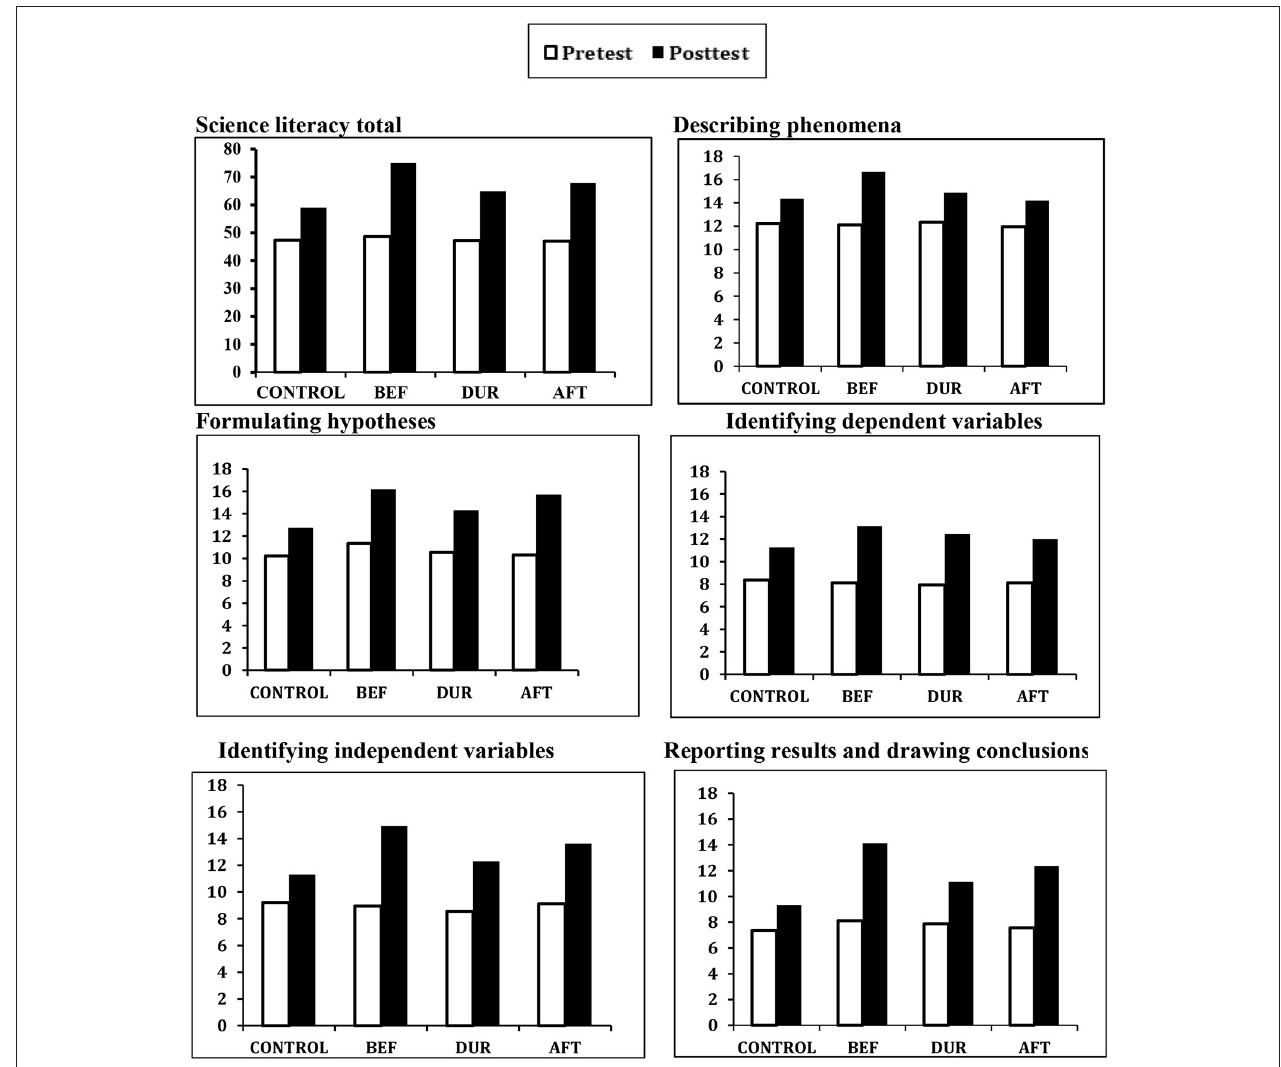
FIGURE 1 | Mean scores on science literacy total and components, by time and treatment. BEF = metamotivation intervention before text reading; DUR = metamotivation intervention during text reading; AFT = metamotivation intervention after text reading; Control = no metamotivation